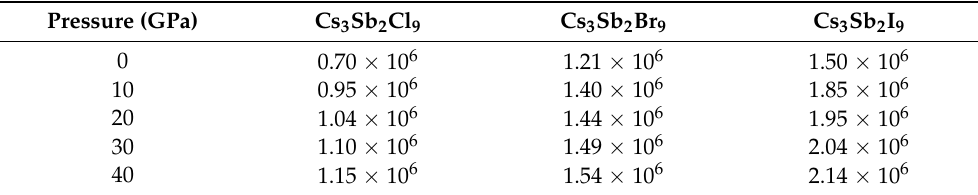
Table 2. The calculated integral value of the absorption coefficient of the Cs 3 Sb 2 X 9 under the pressure from 0 to 40